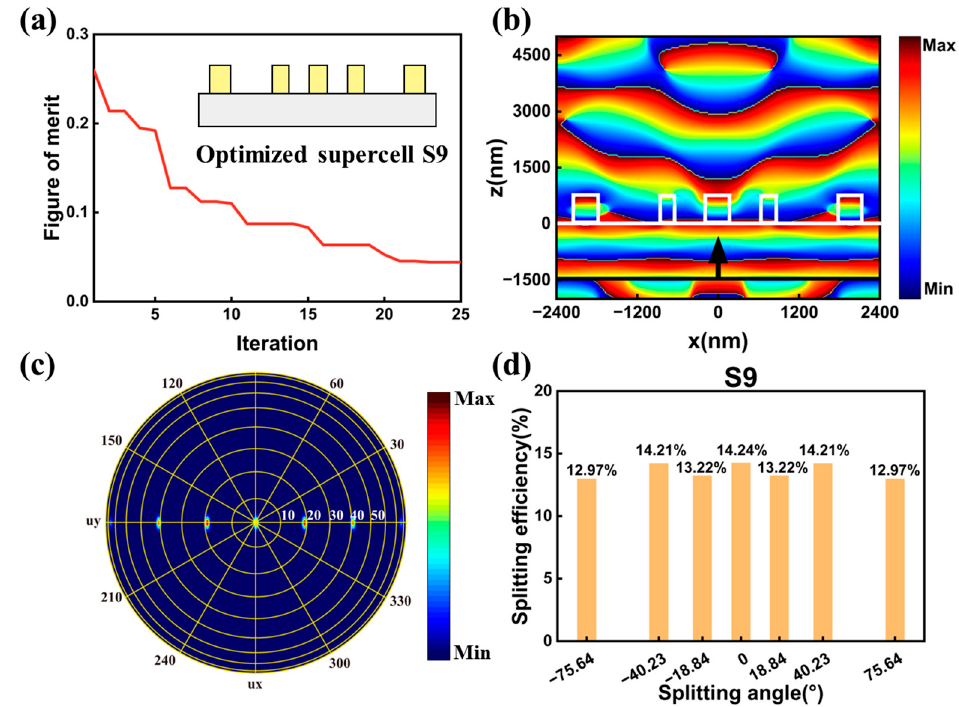
Figure 7. ( a ) The optimization trajectory of metasurface for seven-port splitting output. The insert is the side view of the optimized supercell. ( b ) The phase distribution profile of electric field Ex in the x-z plane for the optimized supercell S9. The white lines depict the boundaries of the nanocylinders and substrate, and the black line and arrow represent the location and direction of the incident light. ( c ) The far field distribution of the splitting channels. ( d ) The calculated efficiencies at different splitting channels in supercell S9.